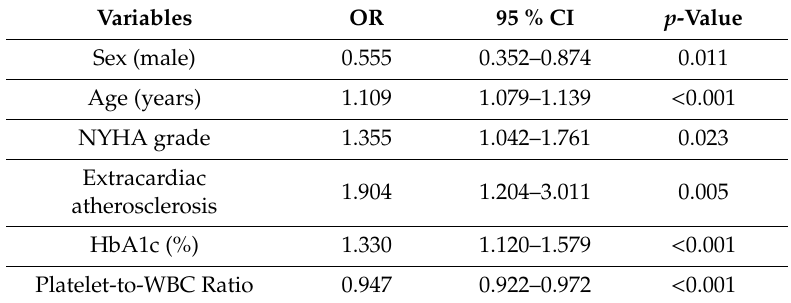
Table 6. Exploratory multivariate logistic regression analysis for selected pre-operative parameters (Wald p < 0.05 threshold) predicting delirium after cardiac